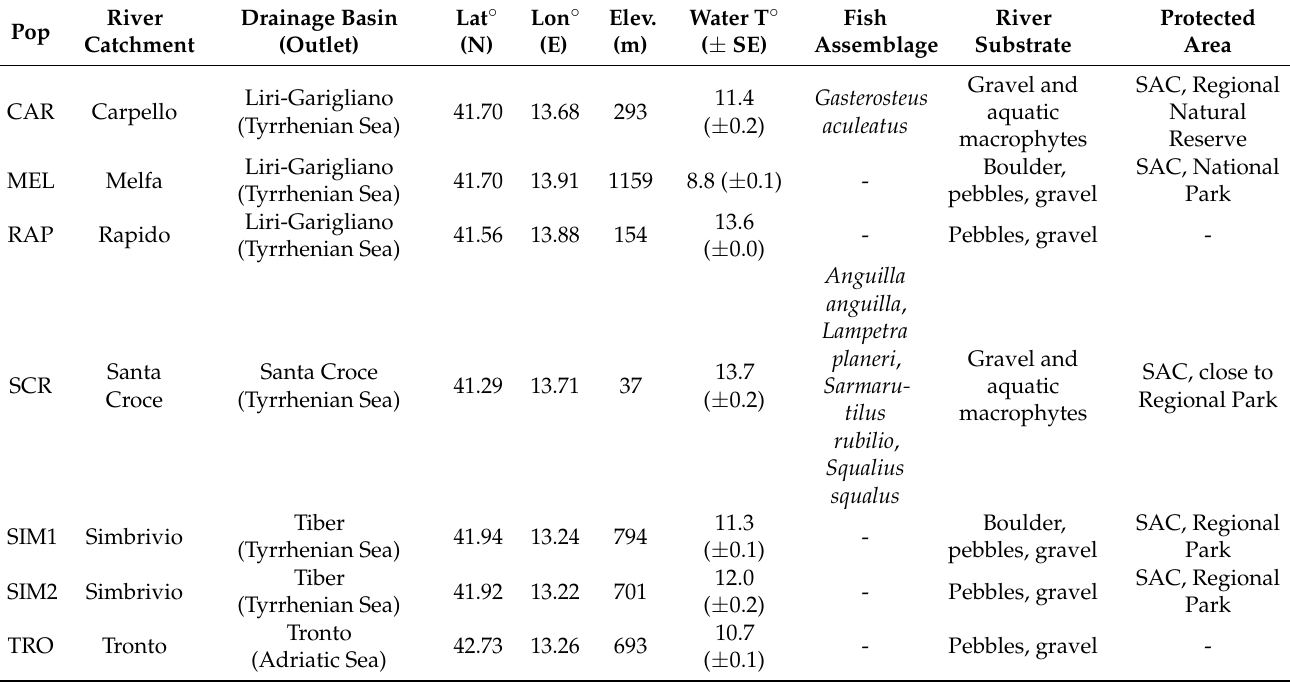
Table 1. Geographic and ecological features of seven sampling sites (Pop) of Mediterranean brown trout from central Italy. The Datum for geographic coordinates is WGS84; SAC stands for Special Area of Conservation; temperatures of water (Water T ◦ ) was measured three times per site in